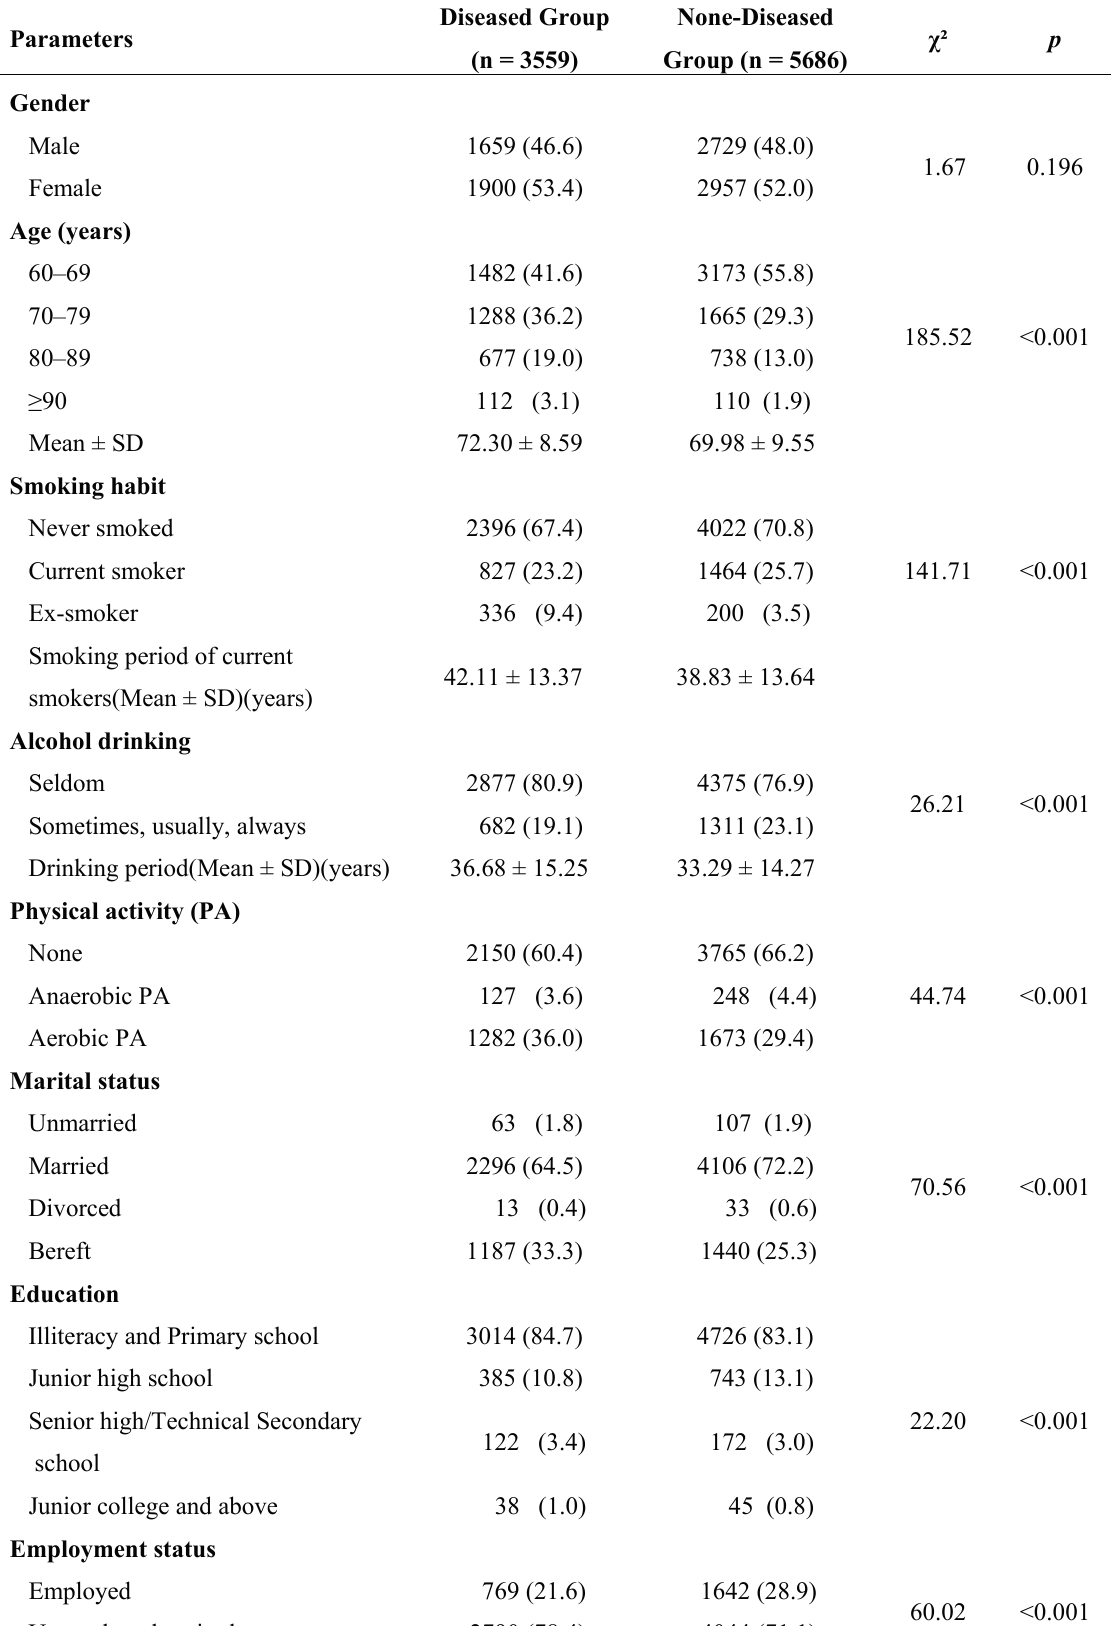
Table 1. Comparison of demographic characteristics between diseased group and none-diseased group of the elderly people, n (n = number,